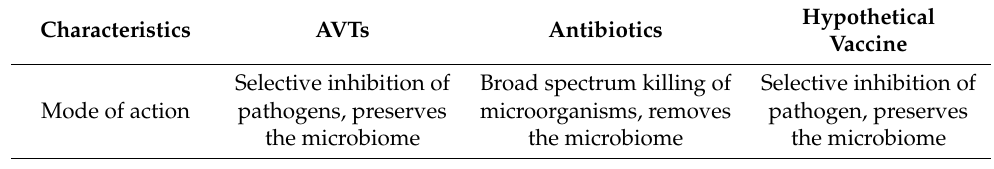
Table 2. Characteristics of AVTs, antibiotics and vaccines *.